Question: Which kind of chart has been used to present this data?
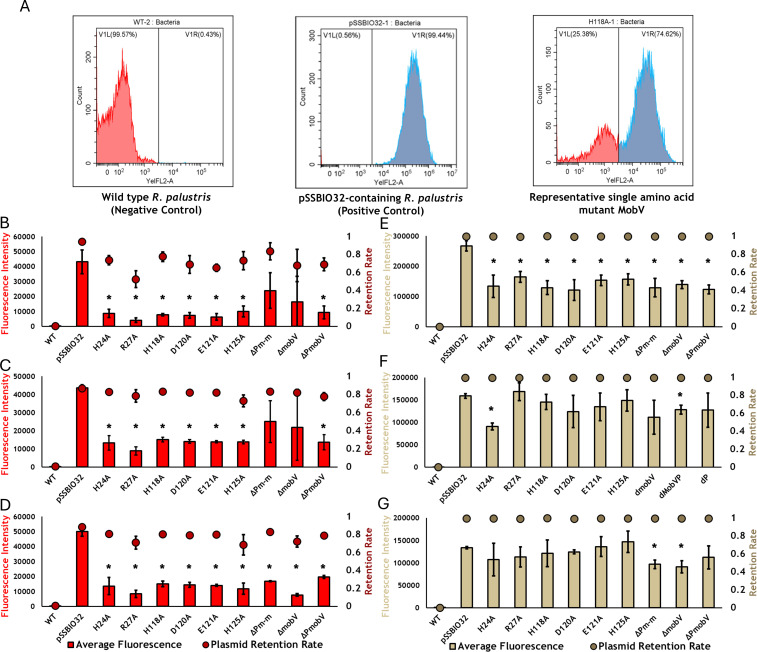
Answer: histogram